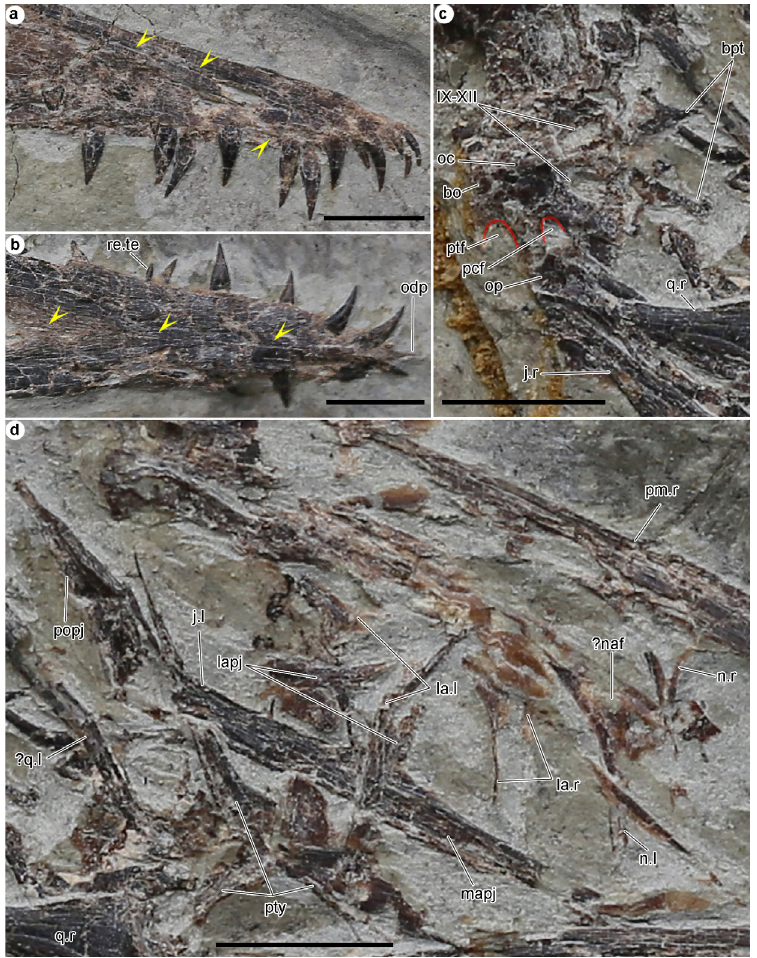
Figure 4. Close-up of the cranial elements of the juvenile individual (STM 19-59). a, anterior portion of the upper jaw, yellow arrows indicating the suture between the maxilla and premaxilla; b, anterior portion of the lower jaw, yellow arrows indicating unfused mandibular symphysis; c, occipital region of the upper jaw, red curves indicating margins of postcranial and posttemporal fenestrae; d, middle region of the upper jaw. Abbreviations: IX-XII, foramina for ninth to twelfth cranial nerves; lapj, lacrimal process of the jugal; mapj, maxillary process of the jugal; naf, nasal foramen; oc, occipital condyle; odp, odontoid process; popj, postorbital process of the jugal; others as in the caption of Figure 3. Scale bars, 4